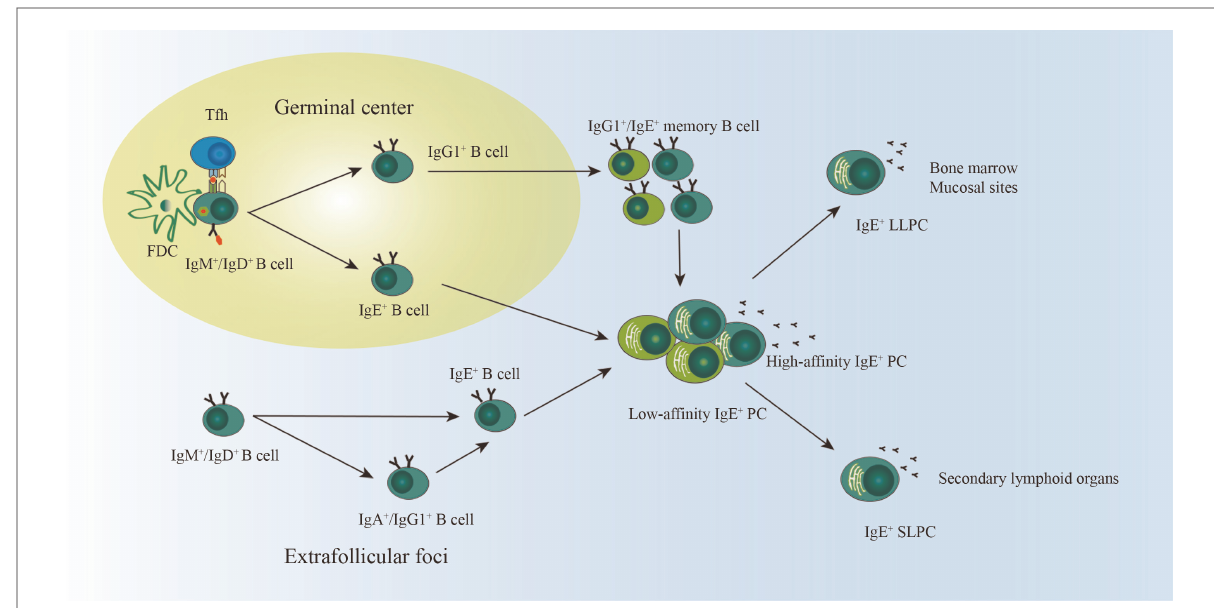
FIGURE 1 The generation of IgE + LLPCs. With the help of FDC and Tfh cells in the germinal center, most naïve B cells experience somatic hypermutation and class switch recombination, including direct class switching (IgM/IgD → IgE) and indirect class switching (IgM/IgD → IgG1 → IgE). B cells experiencing direct class switching are more likely to differentiate into low-af fi nity IgE + PCs. High-af fi nity IgE + PCs may derive from B cells undergoing indirect class switching. IgE + GC B cells, IgE + memory B cells, and IgG1 + memory B cells are precursors of IgE + PCs. A small proportion of IgE + PCs migrate into the bone marrow and become LLPCs. SLPCs reside in secondary lymphoid organs. IgE + PCs can also be generated in the extrafollicular foci and are more likely the SLPCs. FDC, follicular dendritic cell; Tfh, follicular helper T cell; PCs, plasma cells; LLPCs, long-lived plasma cells; SLPCs, short- lived plasma